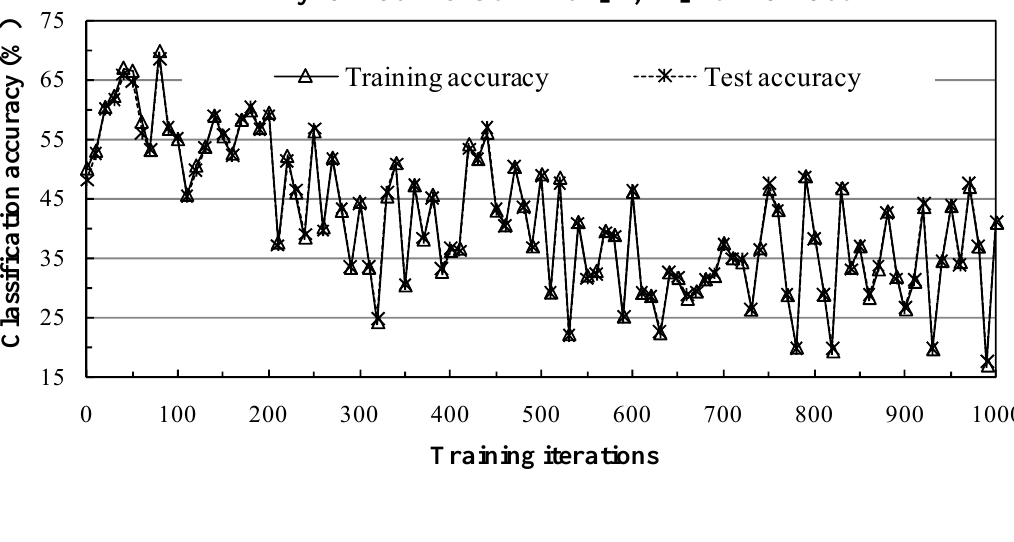
Figure 4. The dynamic subspace method diverged when the [0,1] normalization method was